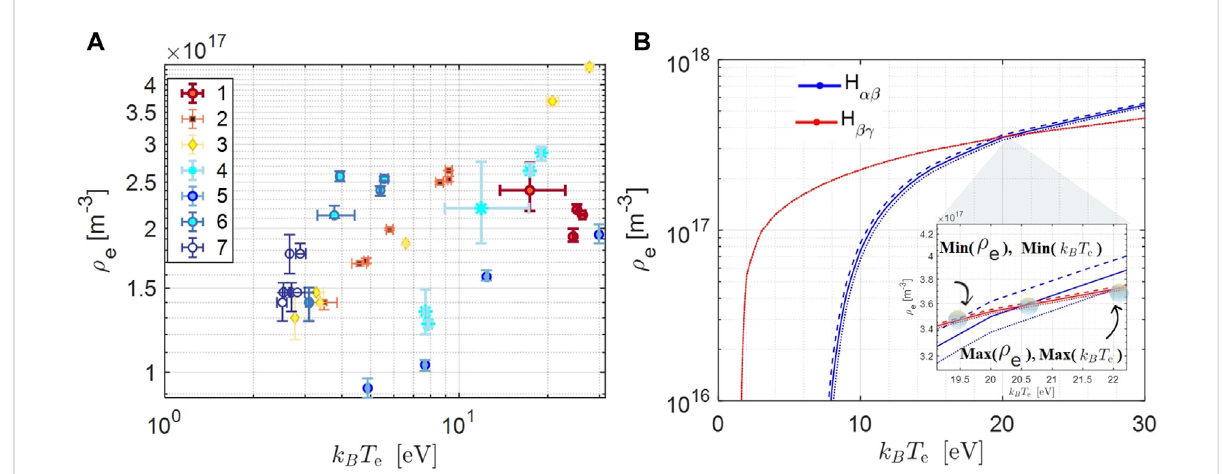
FIGURE 7 (A) Electron density ρ e [m − 3 ] - energy k B T e [eV] grid with uncertainties range (± δρ e , ± δ k B T e ) on both ( ρ e , k B T e ). Points belonging to the same experimental run are labeled according to the Table 2 and indicated in the legend. (B) Typicalcross betweenexperimental line ratios, H αβ , H βγ on the ( ρ e , k B T e ) plane, as arising from Figure 6. Same carried out for the increased (decreased) ratios by respective uncertainties, plot as dashed (dotted) lines. Blobs in the inset indicate the cross, and represent the estimates for the central value and uncertainty on electron density and electron energy. The data refer to the experimental run 3, at f RF = 3.76 GHz, p 0 = 1 E − 03 mbar, and P RF = 350 W.